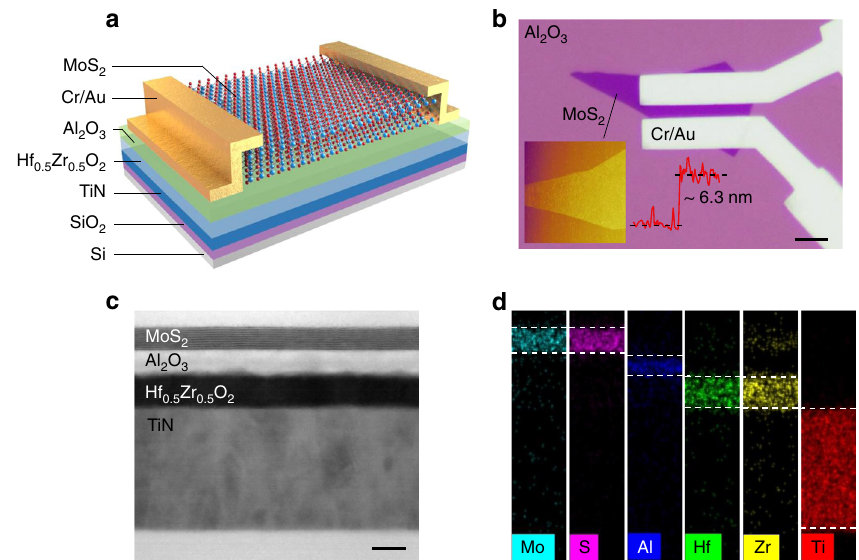
Fig. 1 Schematic of device structure and microscopic representation. a Structure schematic of MoS 2 phototransistors with the ferroelectric HZO thin fi lm in the gate dielectric stack. b Optical microscope photograph of the device with MoS 2 channel length of 3 μ m, width of 15 μ m. Scale bar, 5 μ m. The inset is the atomic force microscope (AFM) imaging of the multilayer MoS 2 fl ake, and the thickness of MoS 2 is measured as 6.3 nm (9 layers). c Transmission electron microscopy (TEM) imaging of the channel and gate of the device is in order with MoS 2 /Al 2 O 3 /HZO/TiN layers. Interfaces of all layers are clear and fl at. Scale bar, 10 nm. d Energy dispersive X-ray spectroscopy (EDS) elemental mapping of Mo, S, Al, Hf, Zr and Ti, corresponding to MoS 2 /Al 2 O 3 / HZO/TiN layers in the TEM